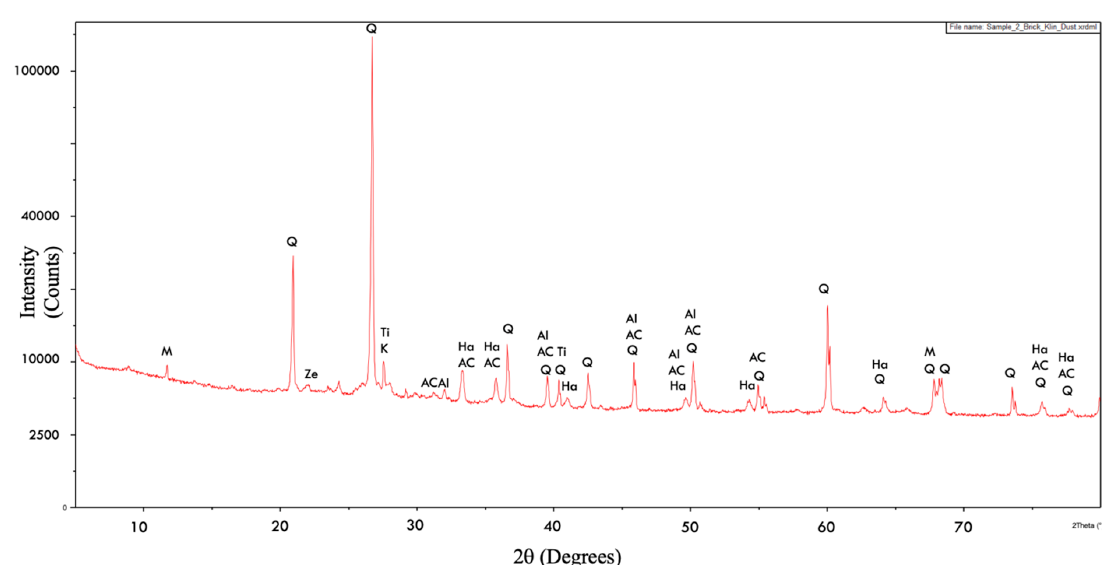
ff ractogram for brick kiln Figure 3. XRD diffractogram for brick kiln dust. Figure 3. XRD di Figure 3. XRD diffractogram for brick kiln dust.